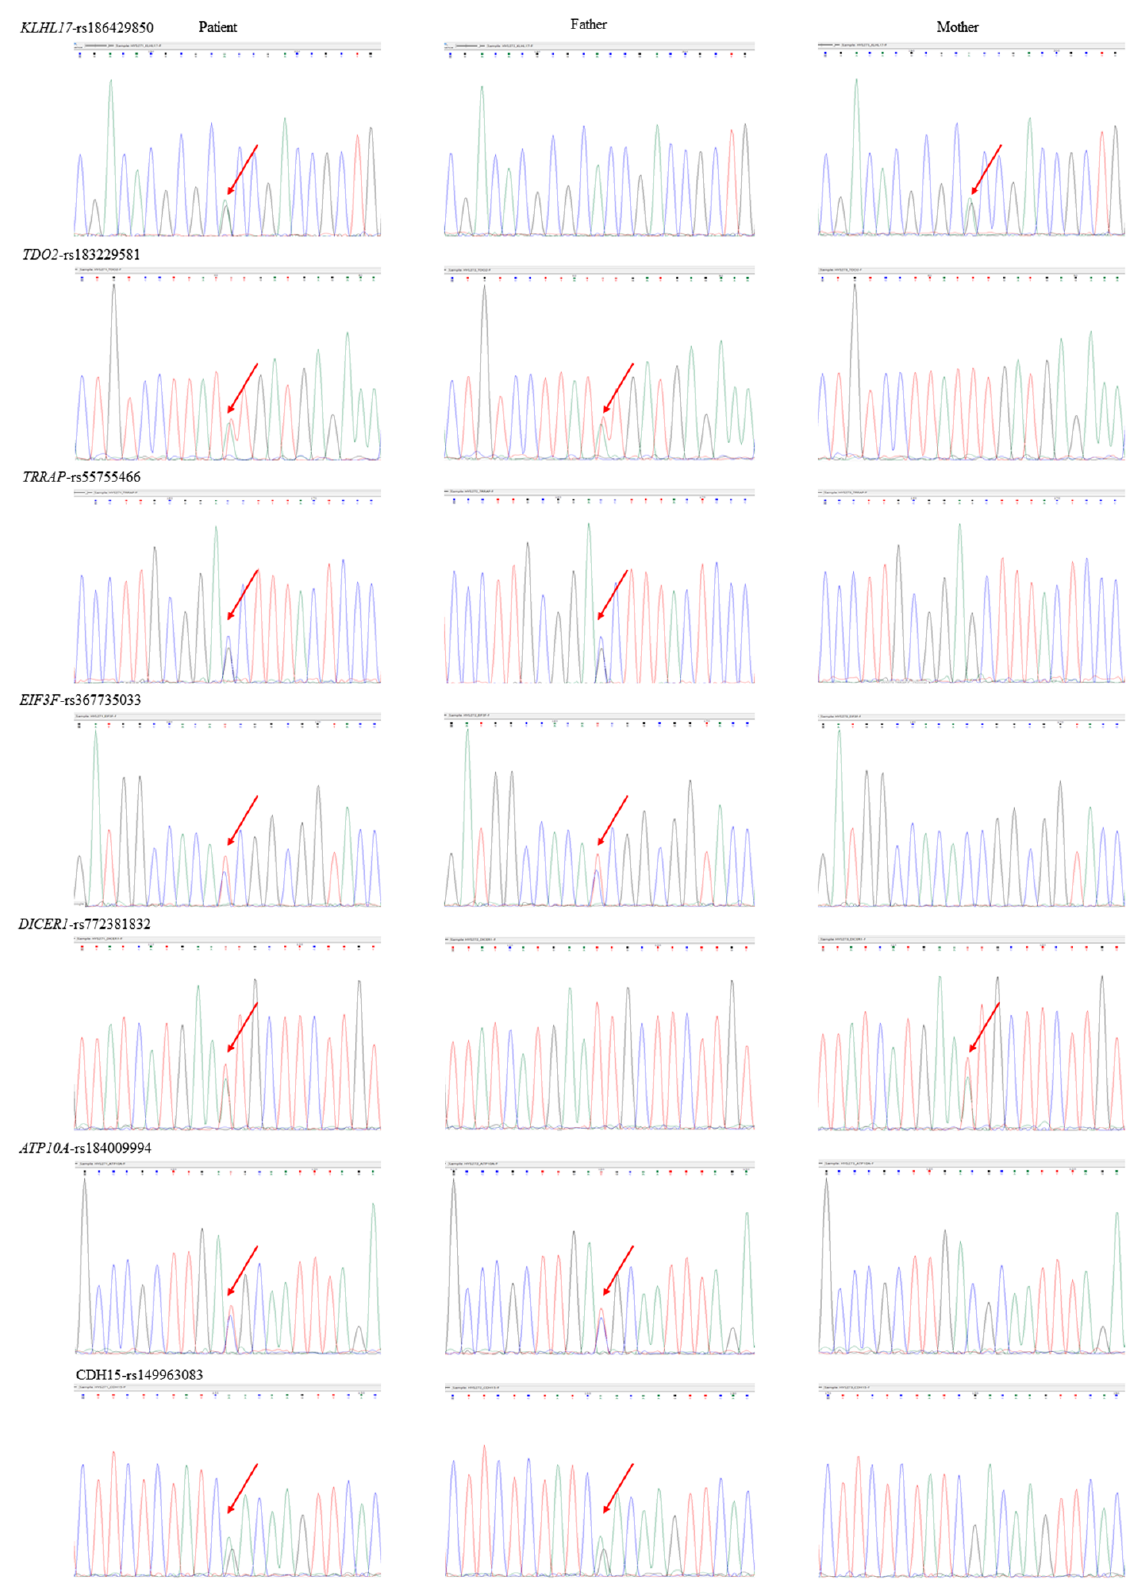
Figure 4. Sanger sequencing verified the authenticity and the origin of the seven inherited missense variants identified in the elder brother. Red arrows indicate the locations of the variants.